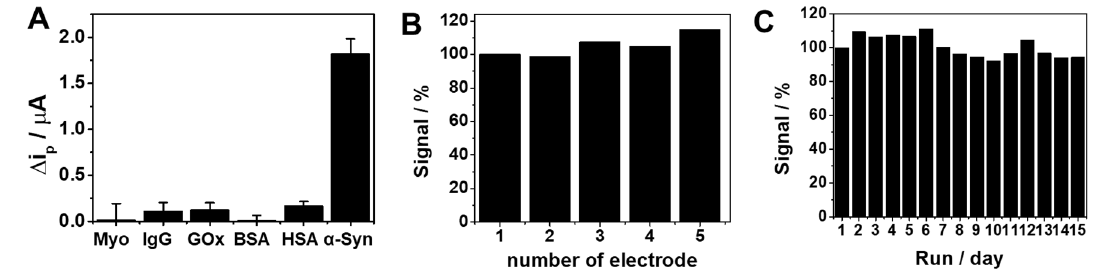
Figure 4. ( A ) Voltammetric responses ( ∆ i p ) of Apt / ERGO-GCE in the absence and presence of α -Syn oligomer and potential interfering proteins (myoglobin (Myo), immunoglobulin G (IgG), glucose oxidase (GOx), bovine serum albumin (BSA), human serum albumin (HSA)) in 0.1 M TBS buffer. Concentrations of α-Syn oligomer and other proteins are 100 pM and 10 nM, respectively. ( B ) Reproducibility of the sensor for five different modified electrodes. ( C ) Stability of the sensor in 15 days under atmosphere conditions.